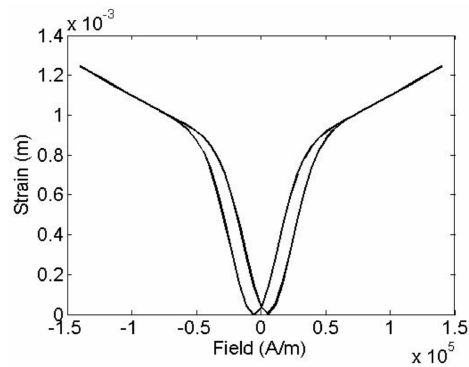
Figure 7. Simulation curve of output displacement and magnetic field strength.